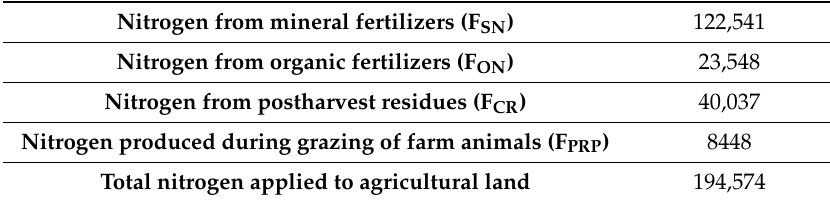
Table 3. Nitrogen inputs to agricultural land in 2017, in tonnes.